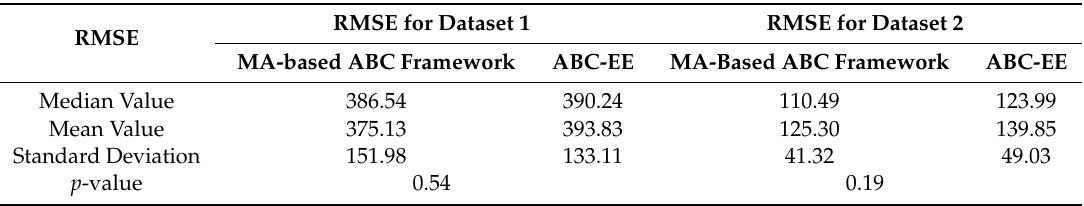
Table 7. Accuracy Statistics of the MA-based ABC Framework and ABC-EE in [16]. RMSE for Dataset 1 RMSE for Dataset 2 RMSE MA-based ABC Framework ABC-EE MA-Based ABC Framework ABC-EE Median Value 386.54 390.24 110.49 123.99 Mean Value 375.13 393.83 125.30 139.85 Standard Deviation